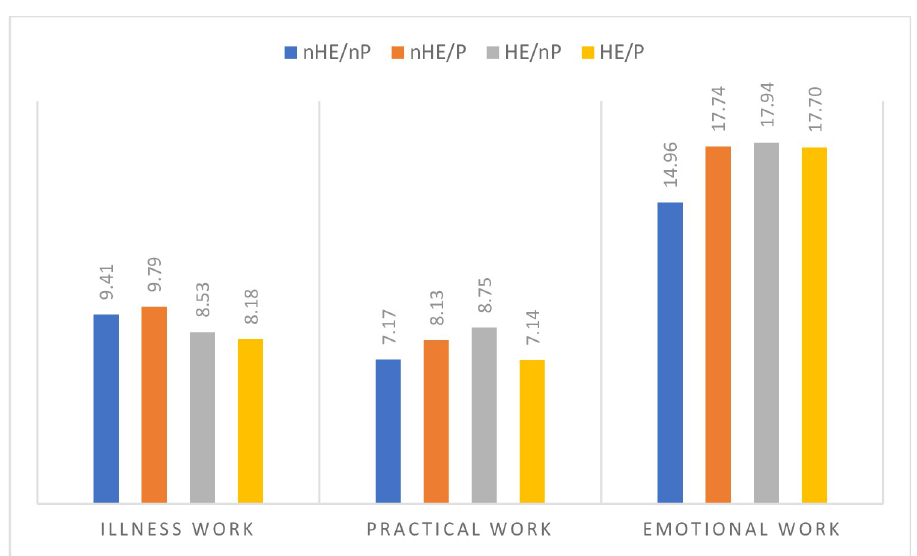
Fig 1. Sum of the mean work per network, for each of the four groups, taking into consideration the mean number of people from each type of relationship.